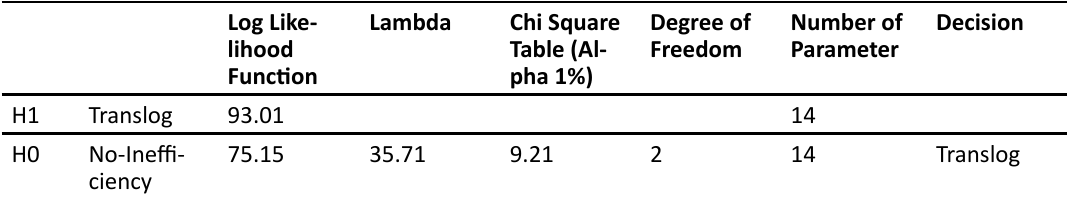
Table 4: Inefficiency